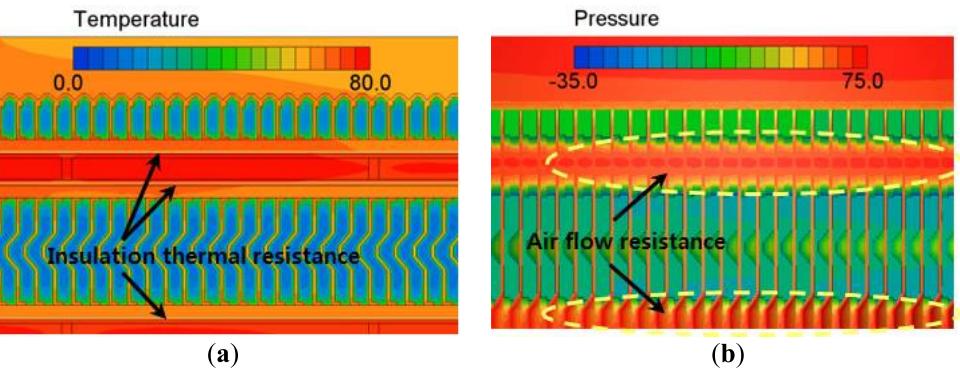
Figure 5. Temperature and pressure distribution of the high-voltage PTC heater modules. ( a ) Temperature distribution ( ° C); ( b ) Pressure distribution (Pa).